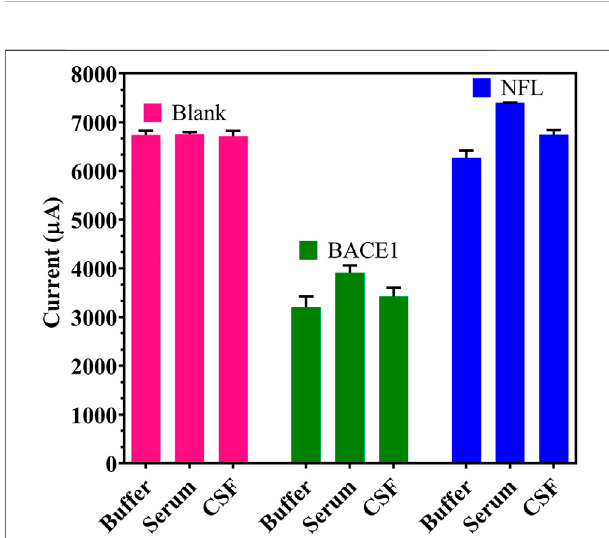
FIGURE6| Speci fi cityofthedevelopedimmunosensor:Cross-reactivity studies with BACE1 and NFL Ag in spiked buffer, serum and arti fi cial CSF.